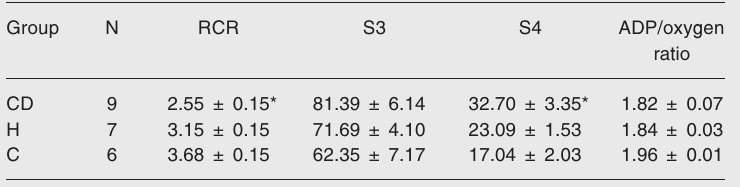
Figure 2. A , Thiobarbituric acid- reactive substances-malondial- dehyde (MDA) equivalents in liver samples. Lipid peroxides are reported as nmol MDA/mg protein. B , Glutathione (GSH) assay in liver samples. GSH concentrations are reported as µg GSH/mg protein. Data are reported as means ± SEM for 7 rats in each group. CD = cho- line-deficient diet; H = high-fat diet; C = standard diet